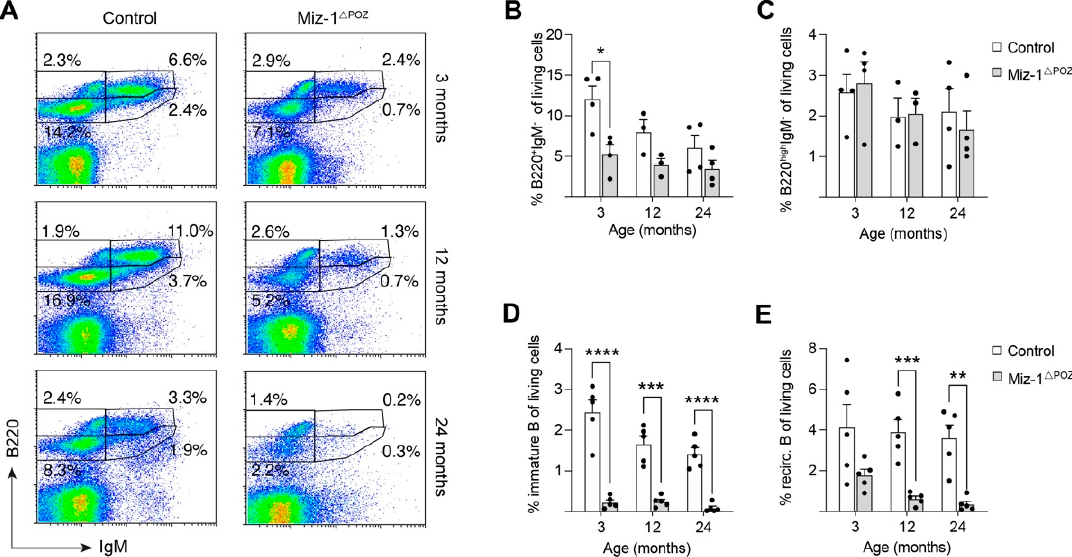
Figure 2. Decrease in immature and recirculating B cell subsets in the bone marrow with age. ( A ) Flow cytometric analysis of bone marrow cells from control and Miz-1 Δ POZ mice. Cells were analyzed with antibodies for B220 and IgM. Cells are pre-gated for debris and doublet exclusion. Percentages in dot plots are given for the respective gates and were corrected to the number living cells. ( B ) Frequency of early B cells (B220 + IgM − ). ( C ) Frequency of B220 high IgM − B cells in the bone marrow. ( D ) Frequency of immature B cells (B220 + CD19 + CD93 + CD43 − IgM + ) in the bone marrow of control and Miz-1 Δ POZ mice at indicated ages. ( E ) Frequency of recirculating B cells (B220 + CD19 + CD93 − CD43 − IgM + ) in the bone marrow of control and Miz-1 Δ POZ mice at indicated ages. One point represents one mouse. Data are expressed as mean + SD ( n ≥ 3). Student’s unpaired t -test: * p < 0.05, ** p < 0.01 *** p < 0.001, **** p < 0.0001. For ( A ), plots are representative of at least five independent experiments.